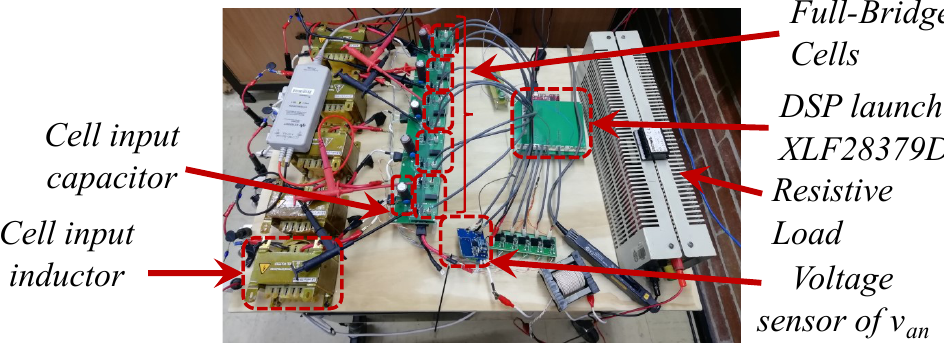
Figure 9. Prototype.